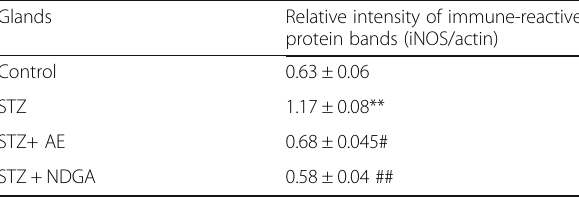
Table 2 Relative intensity of immune-reactive protein bands (iNOS/actin) Glands Relative intensity of immune-reactive protein bands